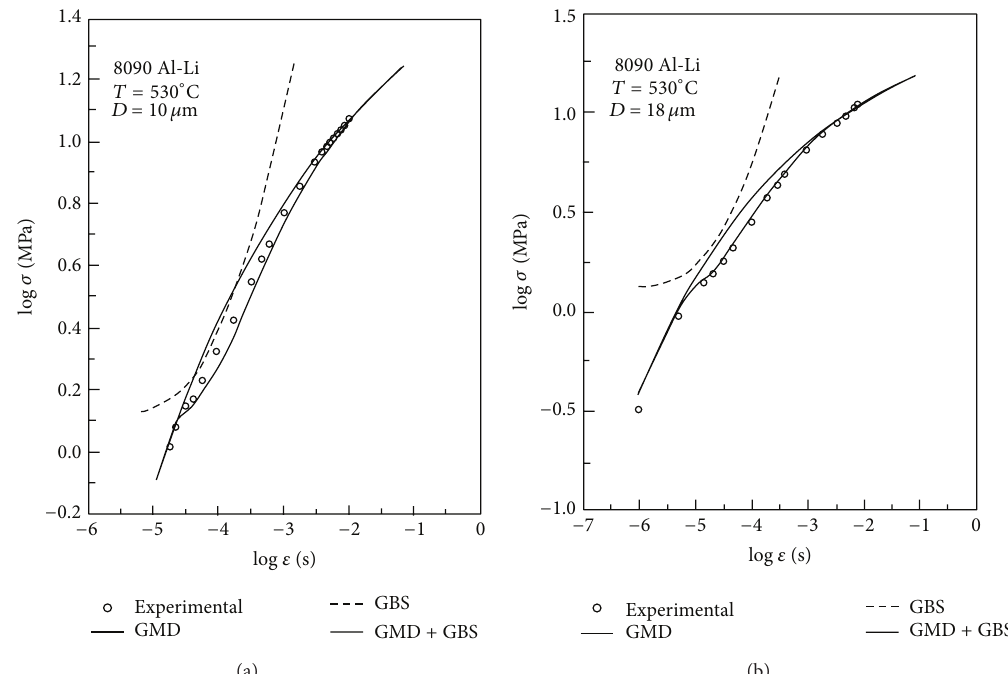
Figure 8: The flow curves are shown to consist of the contributions from GBS ( ̇𝑔 ) and the plastic deformation rate ( ̇𝛼 ) for the specimens with the grain sizes of (a) 10 𝜇 m and (b) 18 𝜇 m at 530 ∘